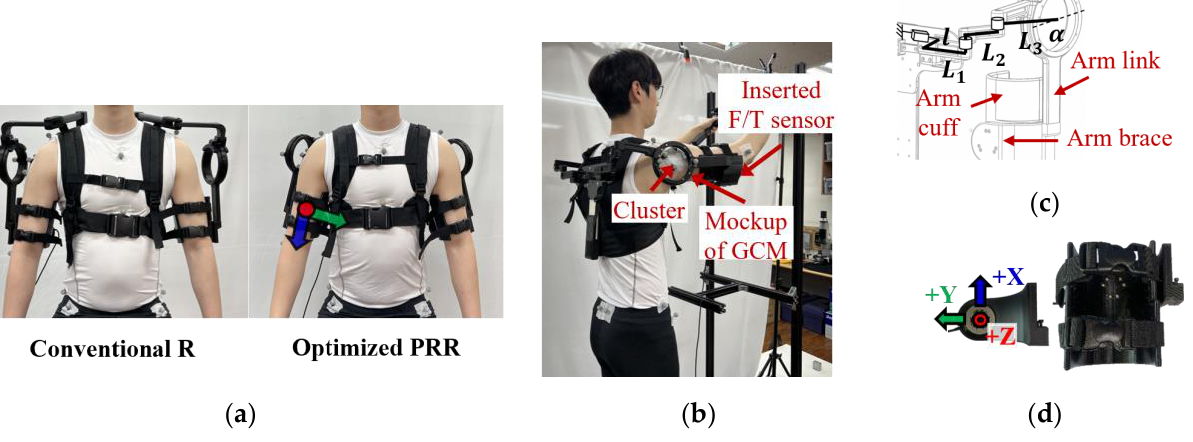
Figure 11. Experimental setup: ( a ) Vest-type skeletal mock-up with different joint configurations. The harness and arm cuff were tightly fastened to a wearer using multiple straps. The red circle and blue and green arrows indicate the three axes of the force/torque (F/T) sensor shown in ( d ). ( b ) Lifting a small box wearing the skeletal mock-up with optimized PRR joint configuration. Skeletal mock-ups for a box and shelf were used in the experiment, and a F/T senser was inserted in the right arm brace. ( c ) Schematics of the optimized PRR configuration and combined frames. ( d ) Position and orientation of the F/T sensor inserted in the arm brace, and the plastic arm cuff.